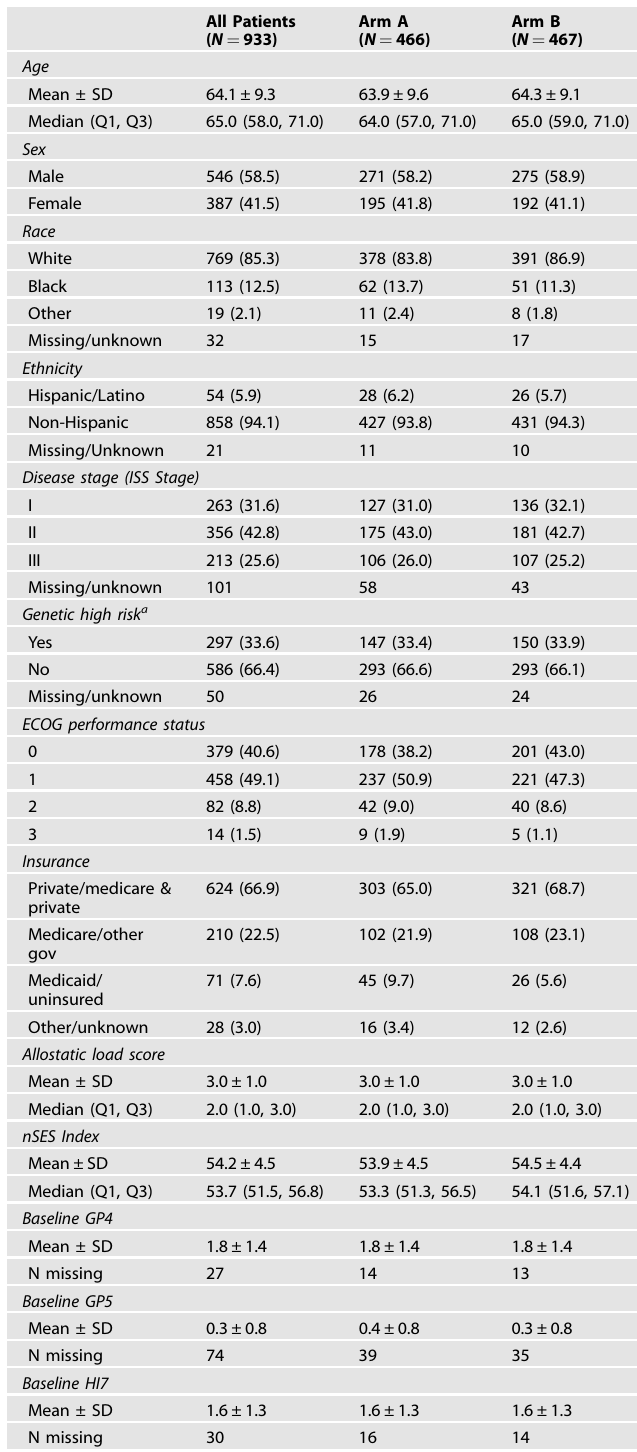
Table 1. Study sociodemographic and clinical